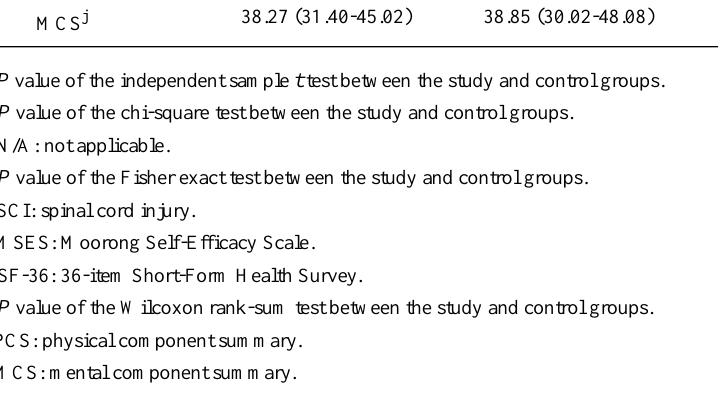
applied to further compare the scores of the study and control groups (Table 5). The total scores and three-factor structure scores at T were significantly higher in the study group than 2 in the control group (total scores: F =8.506, P =.004; social 1 Table 4. There were no differences between the groups in time function self-efficacy: F =8.698, P =.003; general self-efficacy: 1 effects and group effects. However, differences in the interaction effects were statistically significant (total scores: F =20.389, 2,95 P =.01). Trend charts (Figure 5) showed that the total score and P <.001; social function self-efficacy: F =13.445, P <.001; 2,95 scores of the three-factor structures in the study group trended general self-efficacy: F =16.063, P <.001; person function upward over time. In contrast, the scores in the control group 2,95 self-efficacy: F =13.604, P <.001). Simple effect analysis was showed a decreasing trend over 2,95